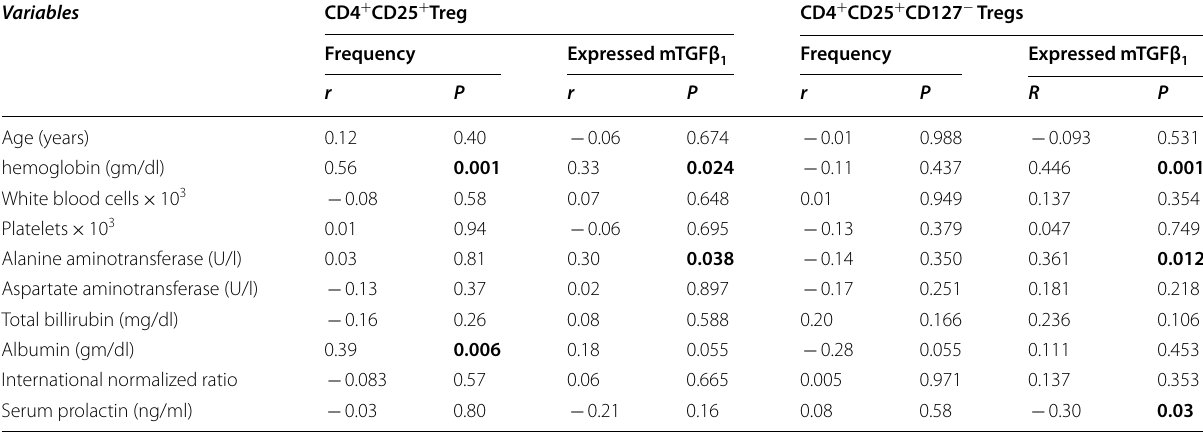
CD cluster differentiation, Tregs T regulatory cells, mTGFβ 1 membrane‑bound transforming growth factor β 1 Correlations were performed using non‑parametric Spearman test. Bold values indicate statistically significant result